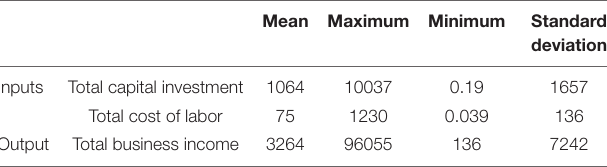
TABLE 2 | Descriptive statistics of input/output variables from 2012 to